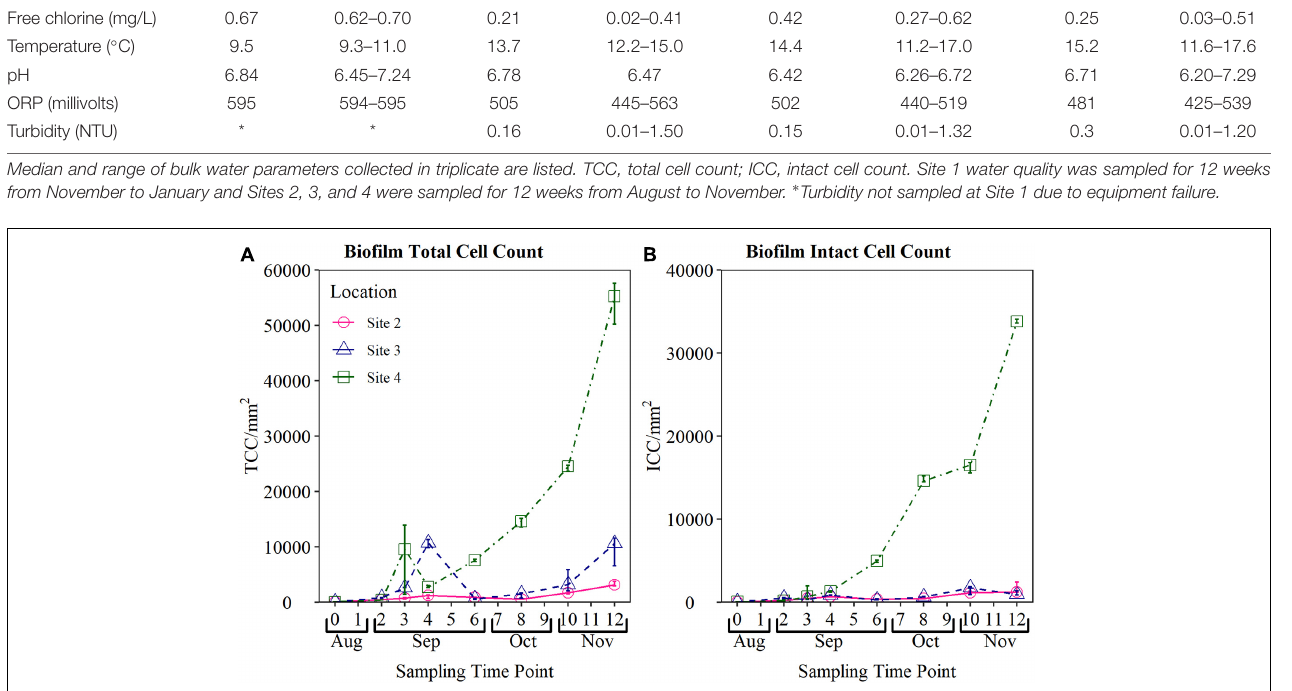
FIGURE 4 | Validation biofouling curves obtained from biofilm monitoring device (BMD) installed at operational field sites. Total cell count (TCC) and intact cell count (ICC) of the biofilm sampled from each BMD are plotted. Biofilm samples were collected weekly for the first 4 weeks, and every 2 weeks from Weeks 4 to 12 (n-3